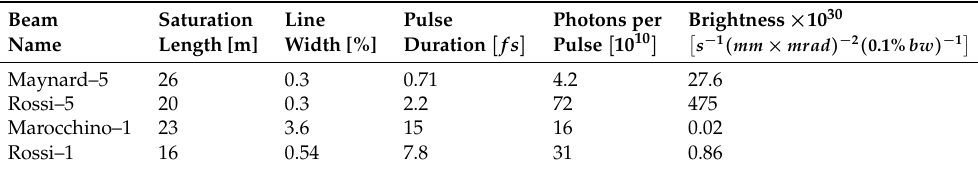
Table 7. Results of the time-dependent simulations with longitudinal dynamics, obtained with PERSEO .